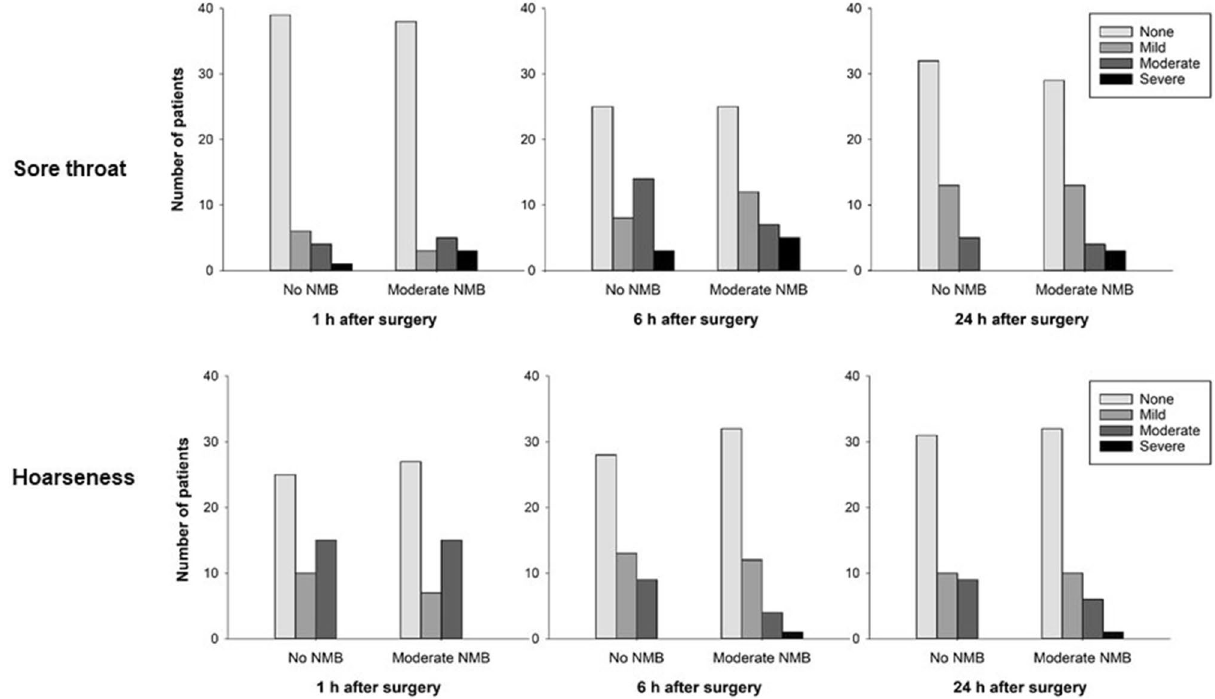
Figure 2. Incidence and severity of postoperative sore throat and hoarseness. NMB neuromuscular